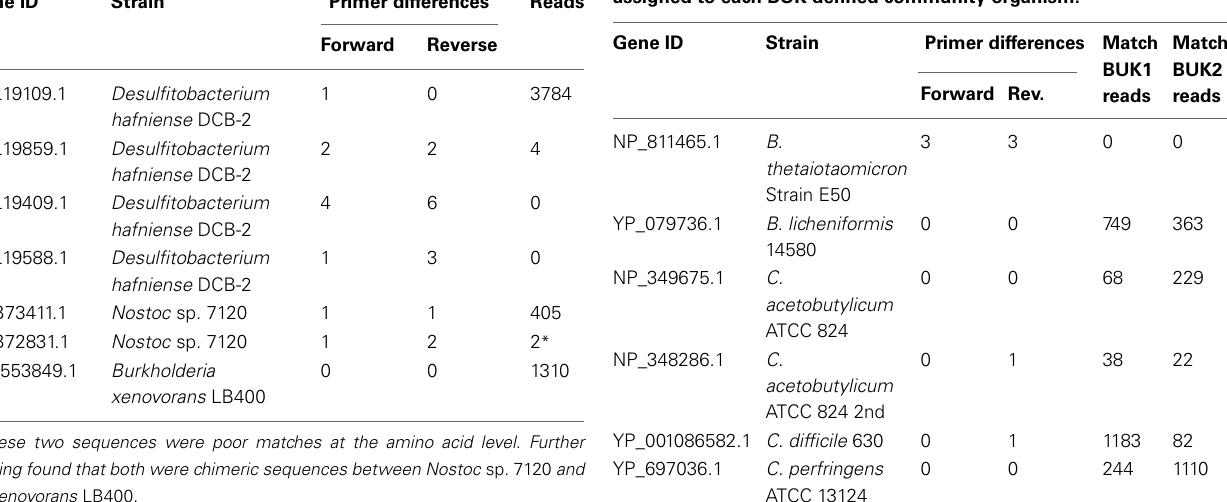
Table 6 | Number of amplicon reads that passed Initial Process assigned to each BUK defined community